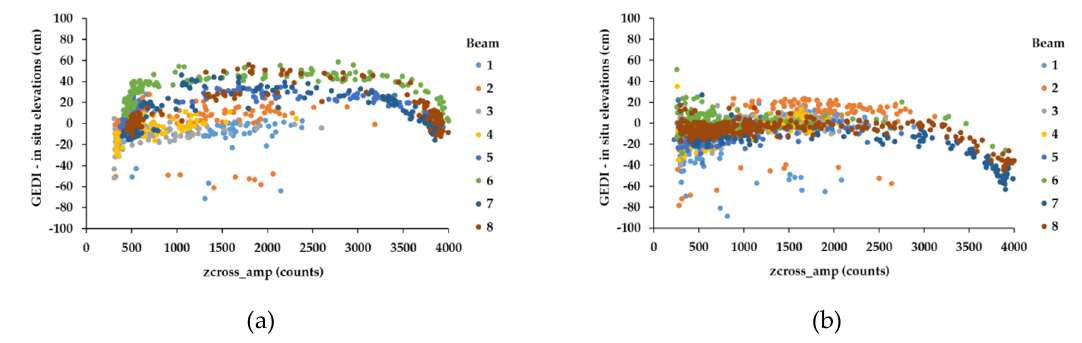
Figure 7. Difference between GEDI and in-situ elevations as a function of zcross_amp using data from all lakes. ( a ) 20 April 2020 GEDI acquisitions. ( b ) 02 May GEDI acquisitions.